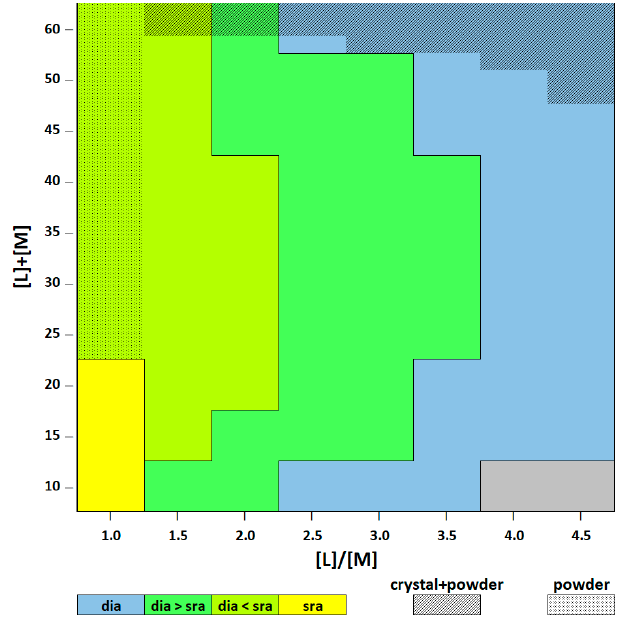
Figure 1. Equilibrium phase diagram for aqueous EtOH solutions (50 vol%) of the CdCl 2 -bpp system, with indication of the stability regions for 3D- sra and 3D- dia polymers as a function of [L] + [M] total concentration and [L]/[M] molar ratio (M = Cd 2+ , L = bpp).